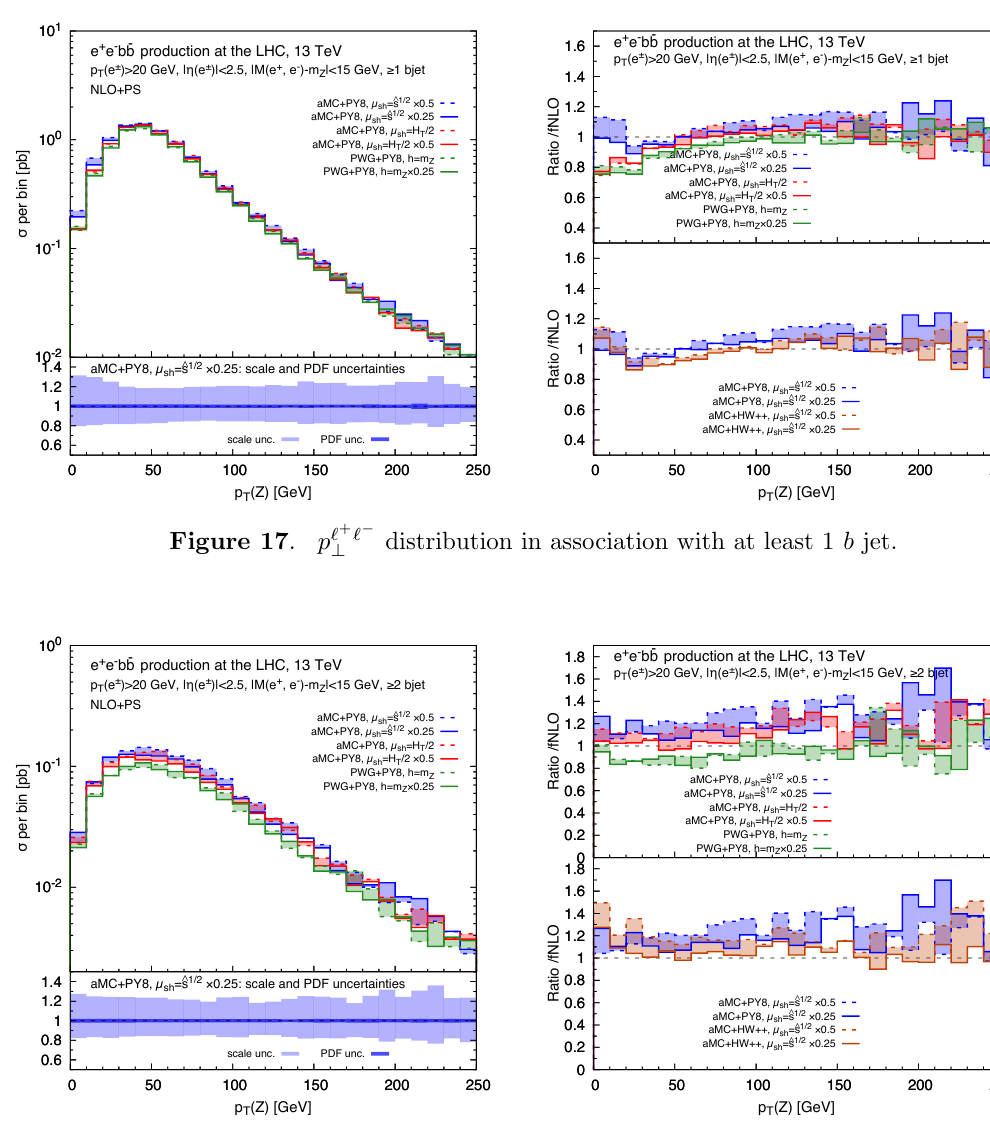
Figure 18 . p ‘ + ‘ (cid:0) distribution in association with at least 2 b ?